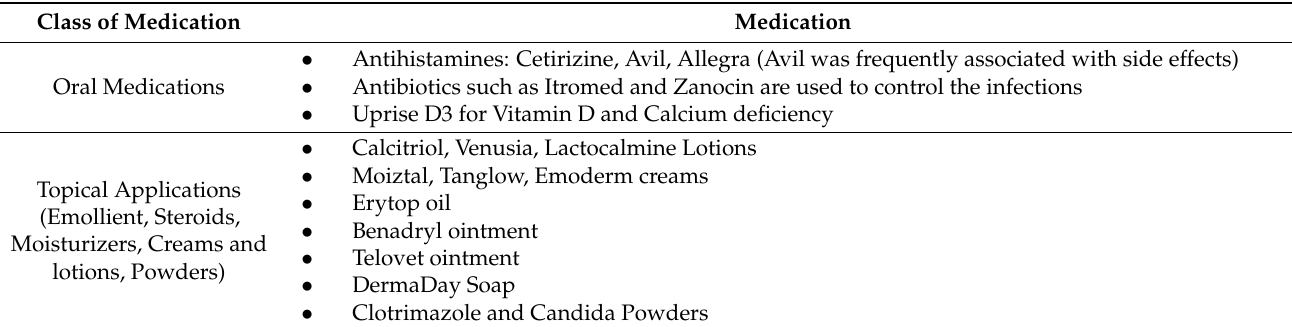
Table 3. Medications taken by